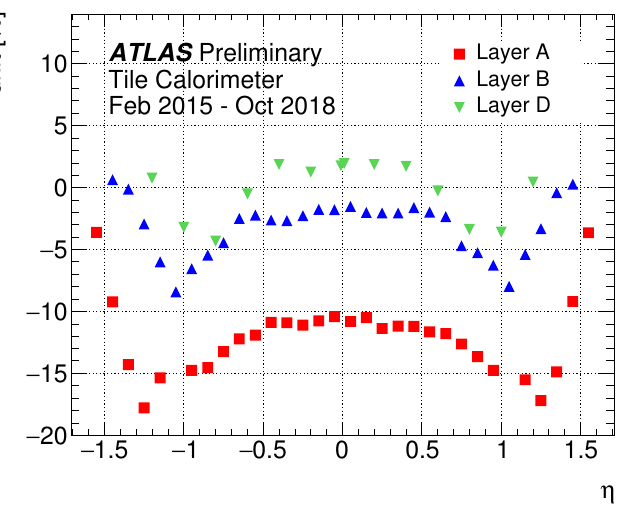
Figure 2. The drift of the Cs response between the beginning and the end of Run-2, shown for cells in different radial layers and as a function of the cells’ pseudorapidity [4]. Cells close to | η | ≈ 1.1 are exposed to higher radiation doses with respect to more central cells in each radial layer.